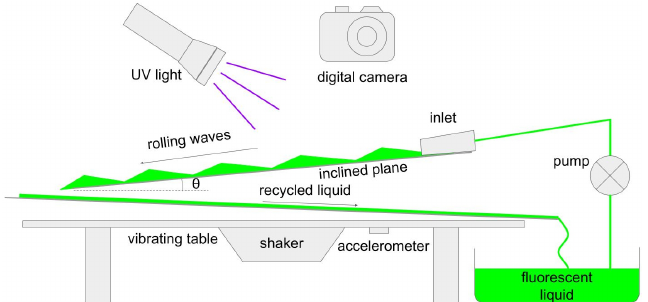
Figure 1. Sketch of the experimental setup used to observe the solitary-like surface waves. For the sake of clarity, only the main constructive features are shown, including the inclined plate, where the waves are observed, the pathway for recycling of the used liquid, and the vibrating table. The dimensions and relative positions of the components in this sketch are not to